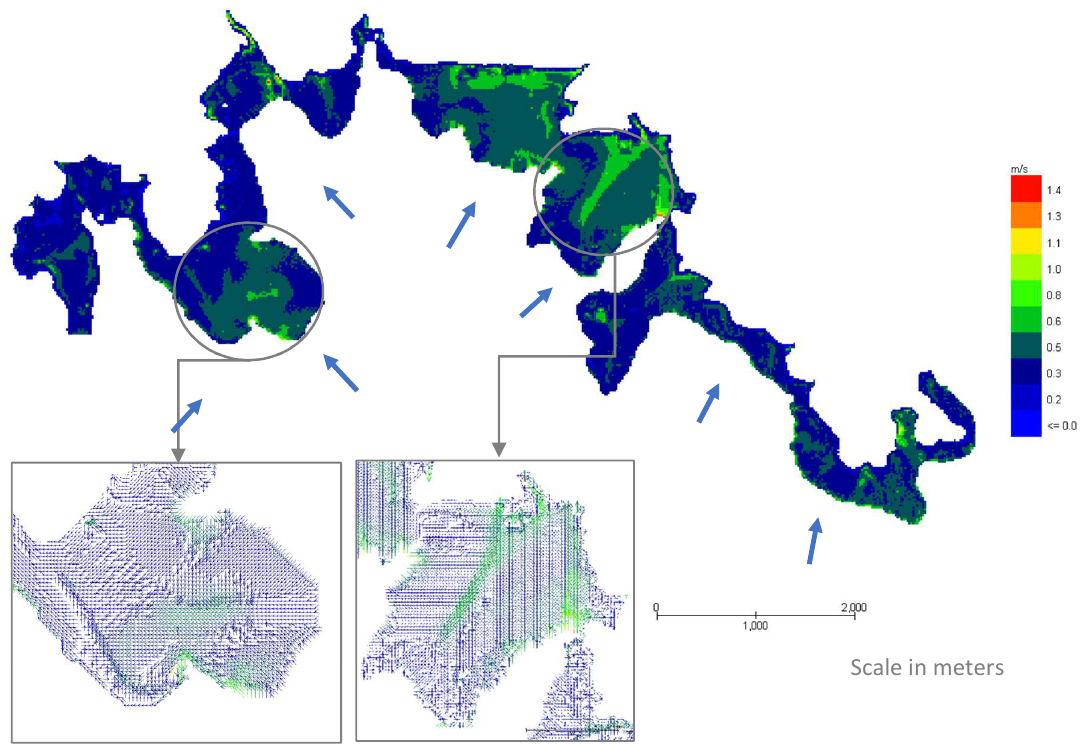
Figure 14. Maximum velocities (ms −1 ) at constant elevation, blue arrows showing inland flow direction. Lower panels display zoomed-in regions showing directional velocity of flow, green and yellow areas having higher velocity flow compared with the blue ones.